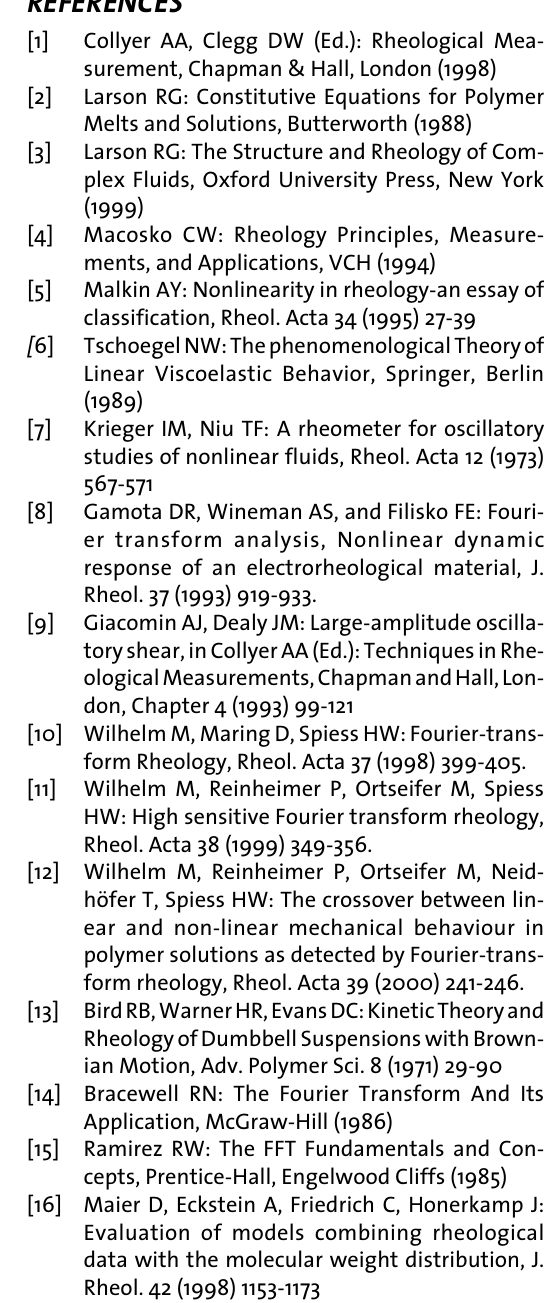
Figure 5c (left): Scheme for extreme cases of the torque response in the time domain and the correlation FT-rhe- ology spectra which is nor- matized to the ground fre- quency, n 1 . In the time domain T 1 expresses the periodicity. A rectangular step function in the time domain yields only odd har- monics in the Fourier spec- tra. A saw tooth figure con- tains both even and odd harmonic of the fundamen- tal frequency, n 1 =1/T 1 . general, an experimental spectra should lie in Figure 5d (right): Relative intensity of the third harmonic I 3/1 ( w 1 ) as a func- tion of the strain amplitude g 0 for PS-250k at T=493 K and n 1 =0.1 Hz (the data set for PS-250k is a result of averaging over three mea-